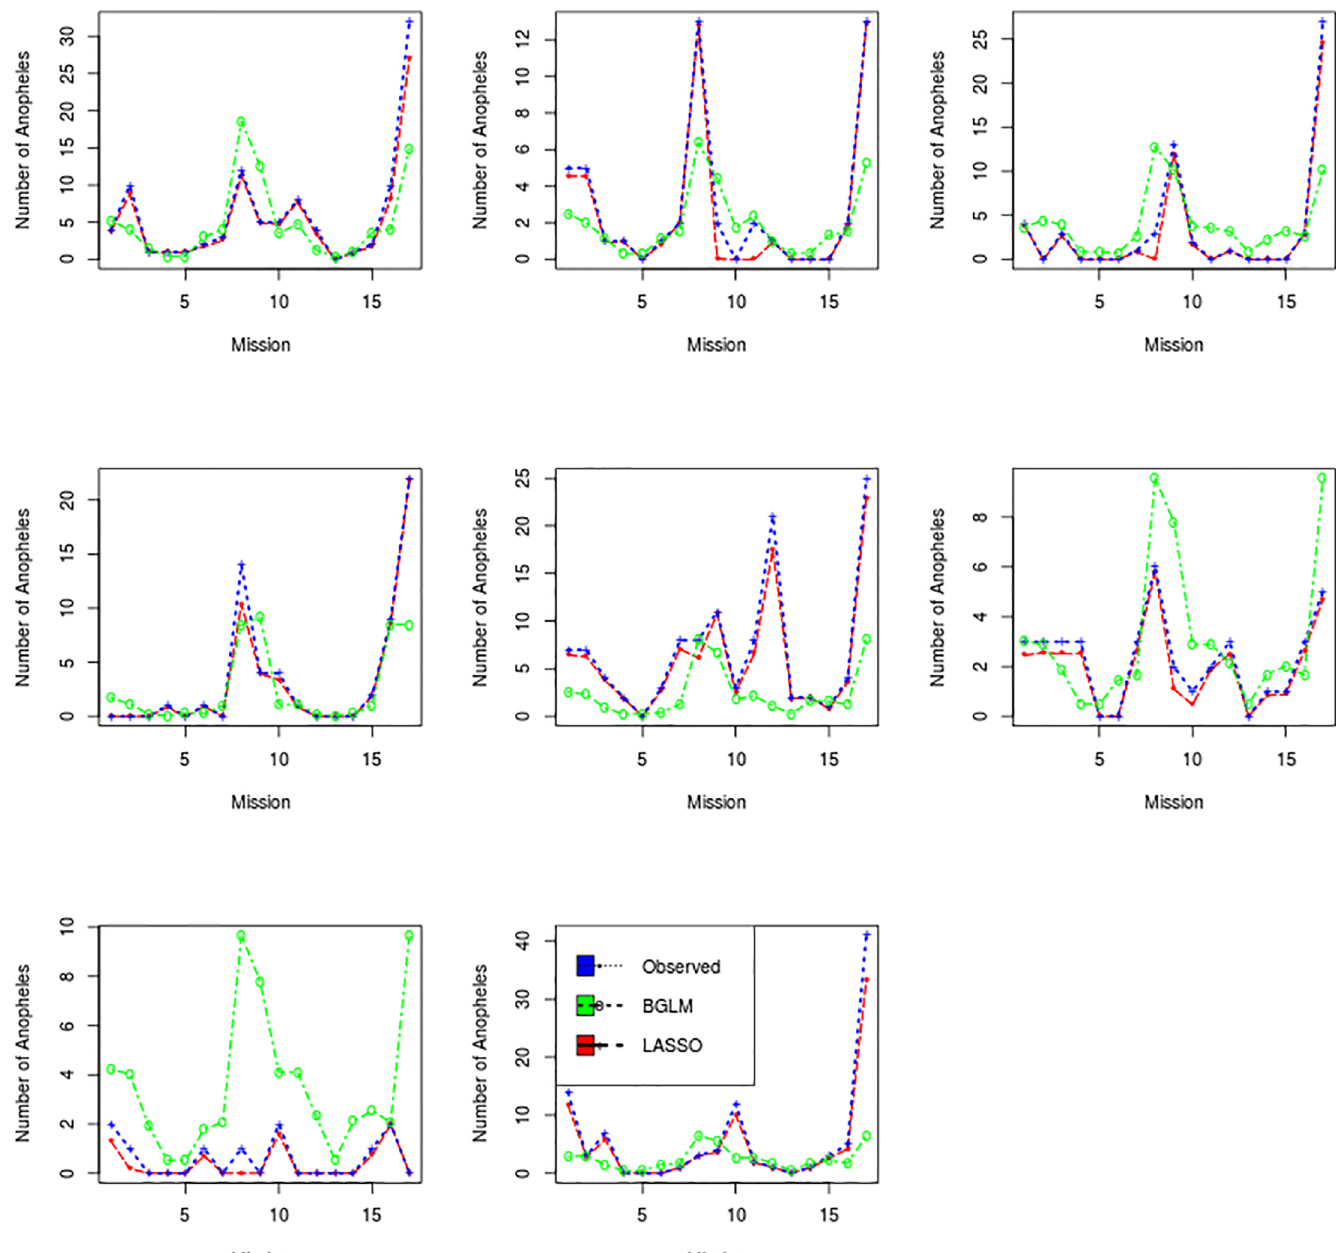
Fig 3. Comparison between observed and predicted number of anopheles in eight houses. The line with “ ? ” is for observedvalues, the line with “o” is for B-GLM and the line with “+” is for